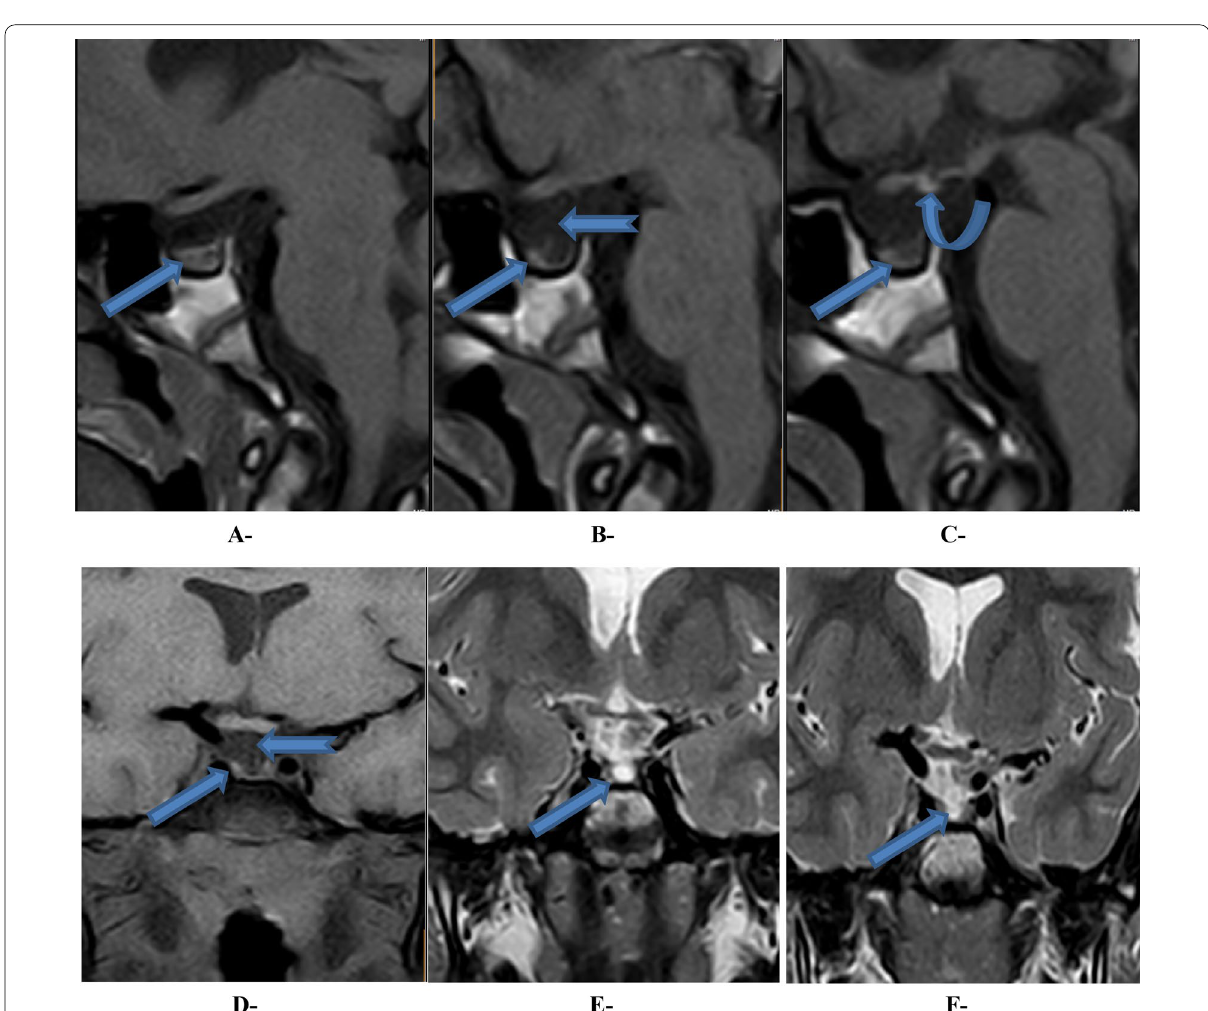
Fig. 2 An 8-year-old boy with signs of pituitary dwarfism. Sagittal T1w non contrast ( A – C ), Sagittal T2w ( D ), Coronal T1w ( D ) and Coronal T2w ( E , F ) showing: hypoplastic anterior pituitary gland (Arrows), hypothalamic ectopic posterior pituitary (Curved Arrows) and absent stalk ( Notched